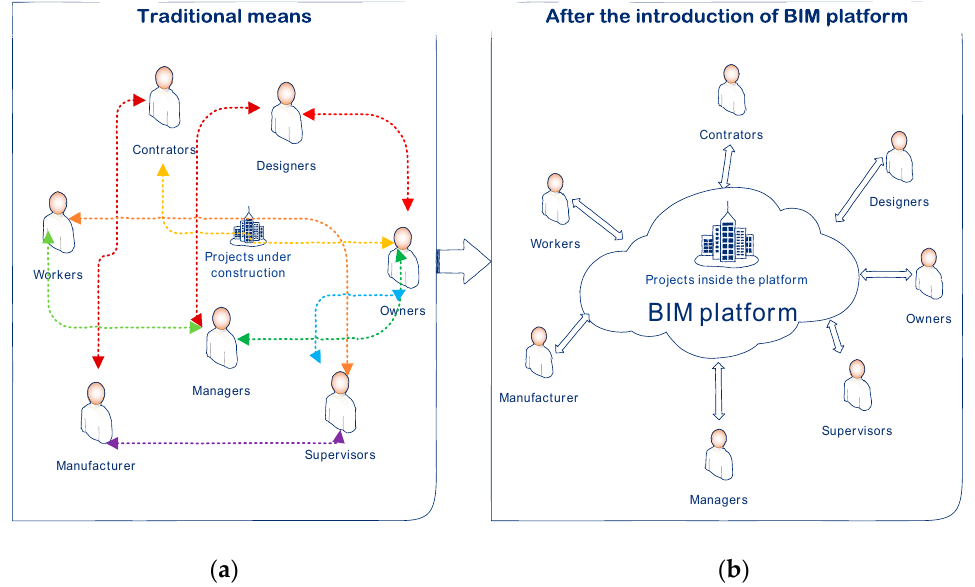
Figure 3. Worksharing: ( a ) traditional means; ( b ) new means after introducing BIM platform.